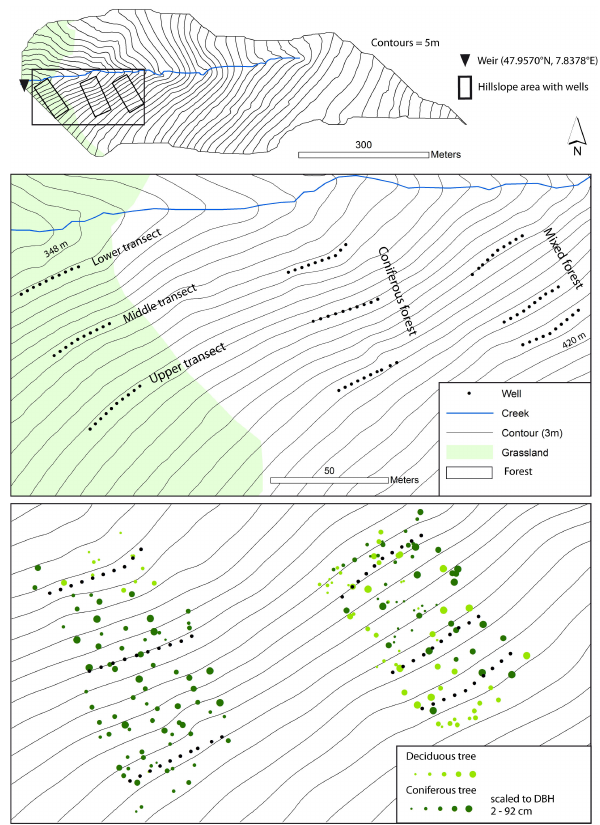
Fig. 1. Overview of catchment and location of hillslopes (top graph), location of wells within hillslopes (middle graph), and loca- tion of mapped trees at the forested hillslopes (bottom graph, DBH= stem diameter at breast height). Catchment area: 0.21km 2 ; eleva- tion range: 340–585ma.s.l.; each hillslope (grassland, coniferous forest, and mixed forest hillslope) is equipped with 30 wells.